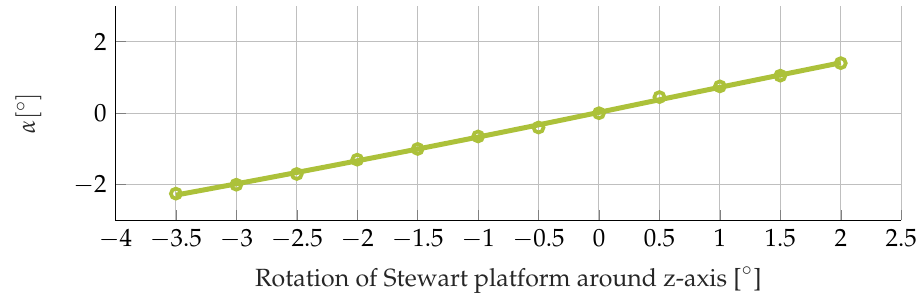
Rotation of Stewart platform around z-axis [ ◦ ] Figure 11. Rotation of the Stewart platform and induced deformation of the flap. The second experiment concentrated on the lateral bending of the flap. In order to evaluate the shape of the flap, a string was strung along the length z f of the flap (see Figure 12). The string serves as a straight reference for the measurement of the value v , which indicates the bending of the flap by its distance to the string. The accuracy of